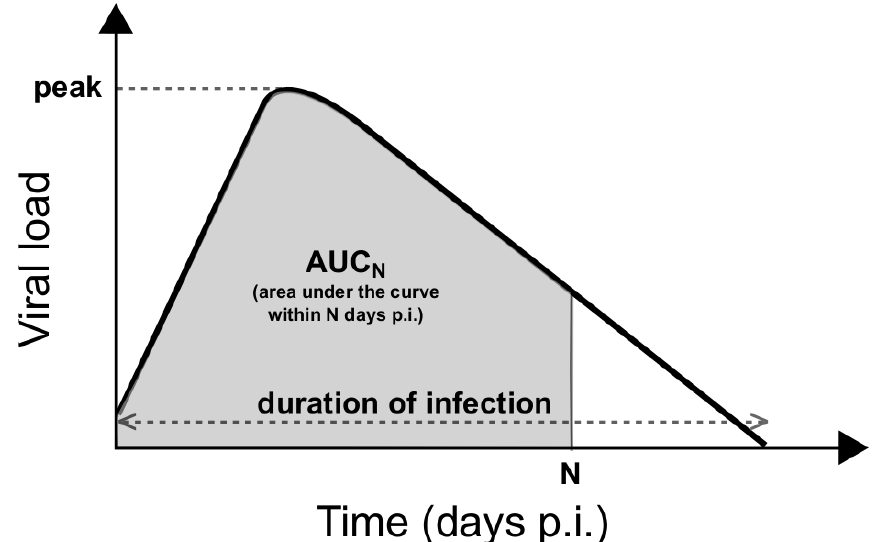
Figure 2. Schematic diagram showing the definitions of three important quantities characterising the viral load profile. Peak viral load indicates the maximum of the viral load curve. Duration of infection is the period of time from the start of infection to the time when the viral load reaches the limit of detection. The area under the viral load curve within the first N days p.i. (AUC N ; calculated by integrating the viral load over the relevant period) is a measure of the cumulative viral load over a certain period of